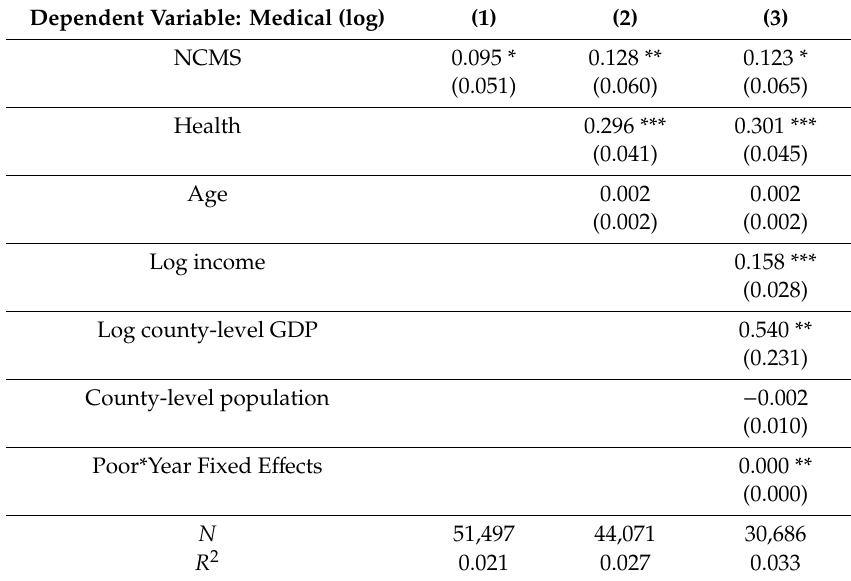
Table 4. E ff ects of the NCMS on Medical